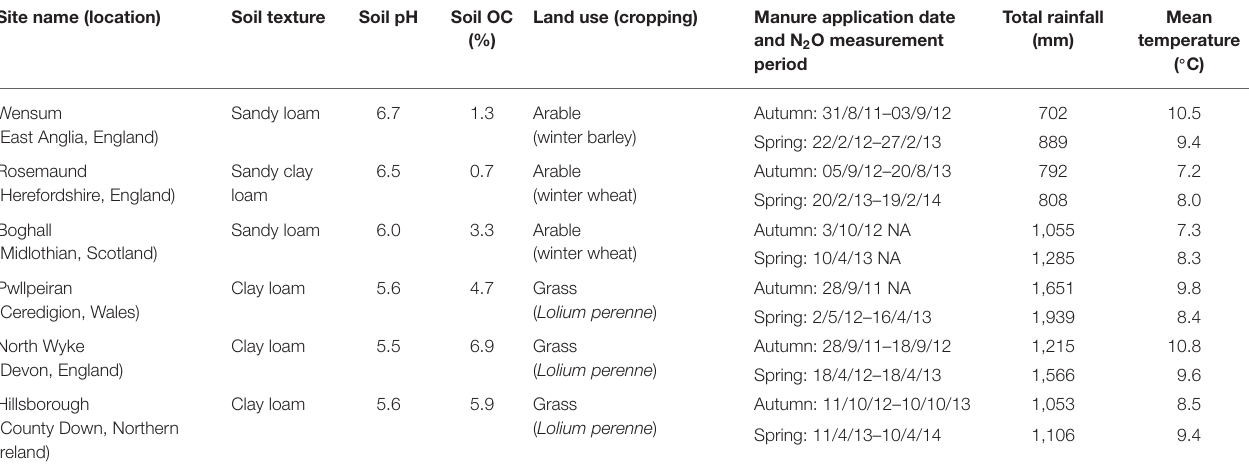
TABLE 1 | Details of the experimental sites, including soil properties, total rainfall, and mean air temperature over the measurement period. Site name